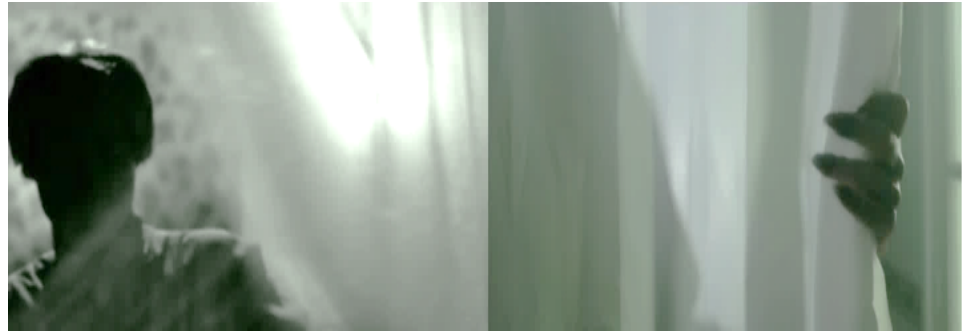
Figure 15: The Psychopath in Psychosis and The Witch in Dashra : both mysterious The partial appearance (hands or silhouette) of the mysterious witch several times in Yasmine's mind, also implicitly appeals to Norman Bates, the fictional character in Psycho, who disguised himself as her mother during her murder of Marion Crane when she was showering at the motel, not to mention the motel itself in Psycho: that isolated spatial setting full of mystification, to which Bouchnak appeals through the lonely house of Dachra, where Yasmine and Bilel were taken in, as well as Walid who was doing nothing but watching them, and through whose location he clearly reminds us of Hitchcock's location at the Bates